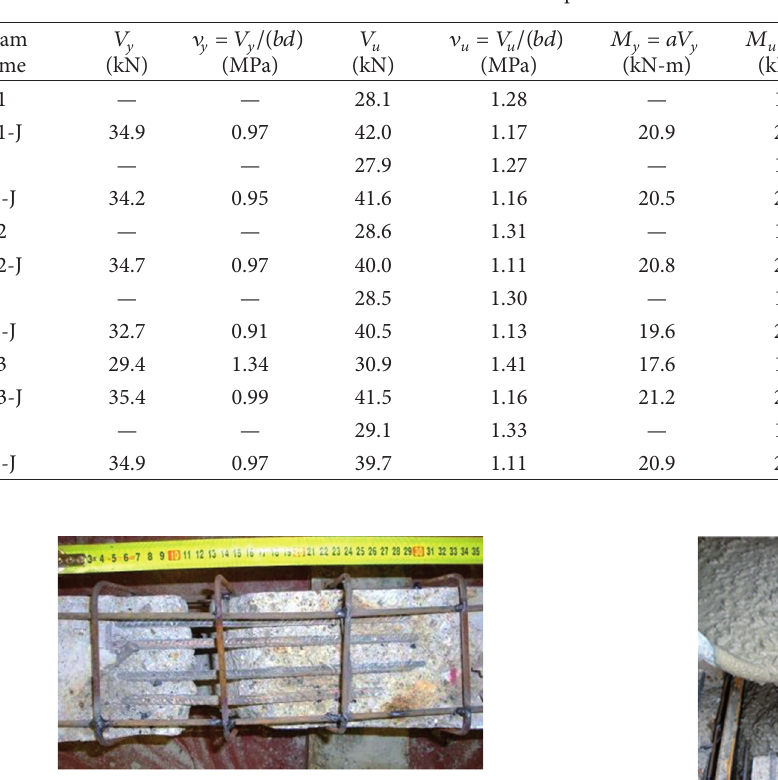
F 3: Typical installation of the jacketing steel reinforcement (view from the bottom of the original damaged beam).